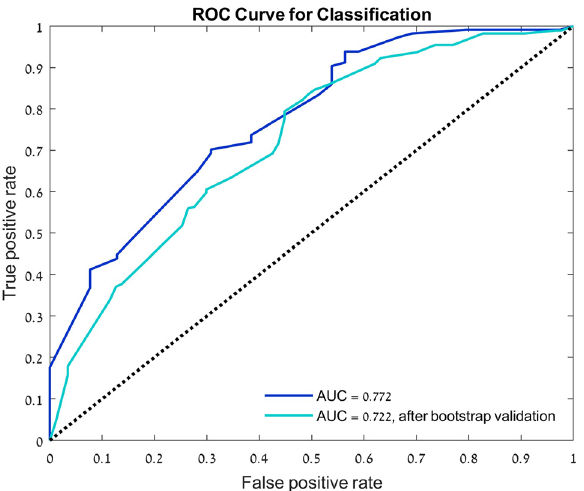
Figure 5. Validity of the predictive performance. Receiver operating characteristic (ROC) curves for the classification the multivariate logistic regression